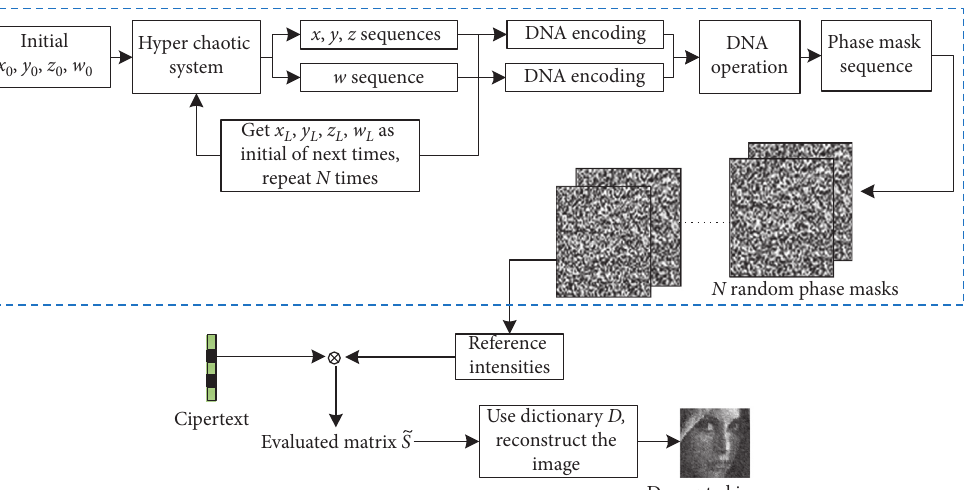
Figure 4: CSGI encryption.